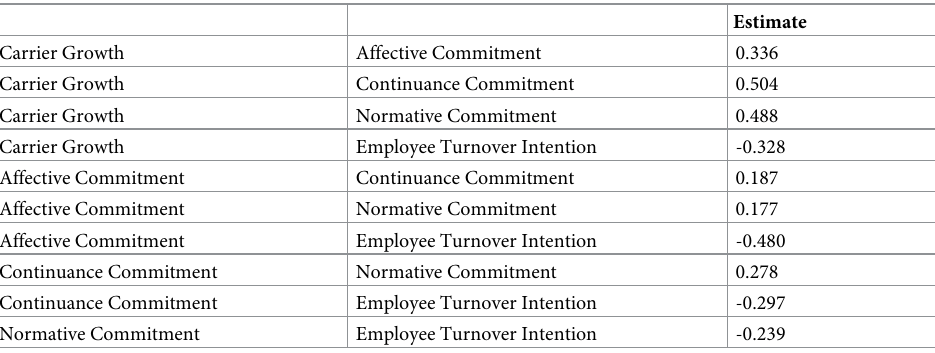
Table 3. Correlations: (Default model).